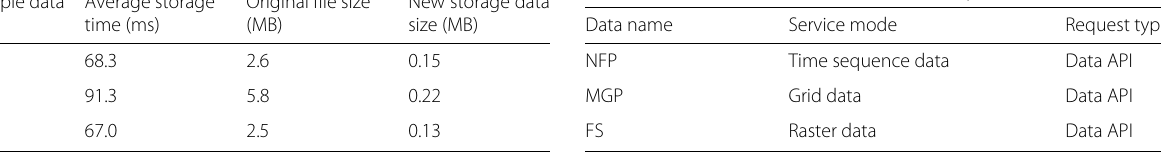
Table 4 Evaluation method of the service